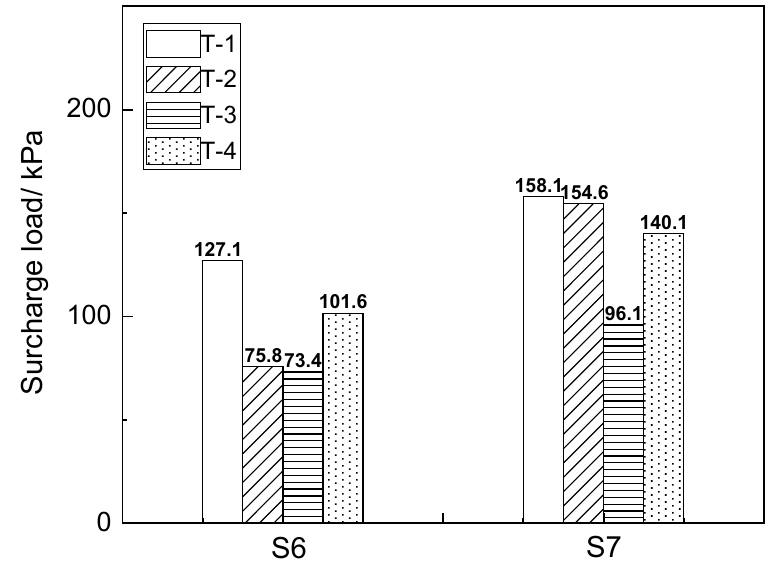
Figure 5. The surcharge load corresponds to the peak earth pressure.